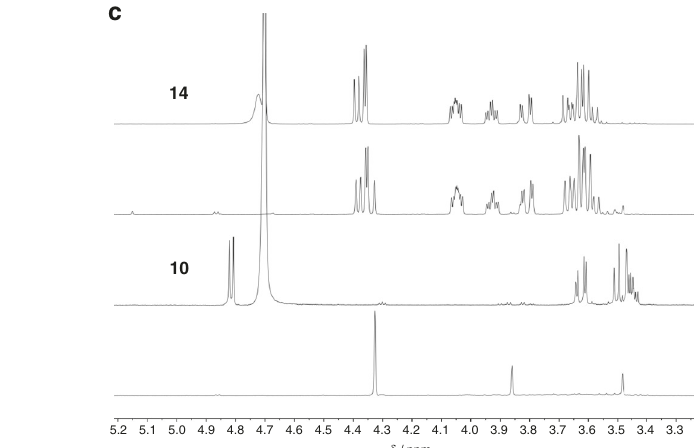
Fig. 4 Protection and concentration of aldehydes. 1 H NMR Spectra showing how aldehydes can be protected and concentrated under prebiotically plausible conditions via the intermediacy of their bisul fi te adducts. a aldehyde = formaldehyde 2 ; b aldehyde = glycolaldehyde 5 ; c aldehyde = glyceraldehyde 10 . Upper spectra — solution of aldehyde, NaH 2 PO 4 and HSO 3 – ; centre upper spectra — as upper spectra after heating to dryness for 40 h then redissolving in D 2 O; centre lower spectra — as upper spectra without the addition of HSO 3 – ; lower spectra — as centre lower spectra after heating to dryness for 40 h then redissolving in D 2 O (in a , the singlet observed at 3.3 ppm, upper and centre lower spectra, is MeOH, included in commercial formaldehyde as a stabiliser)